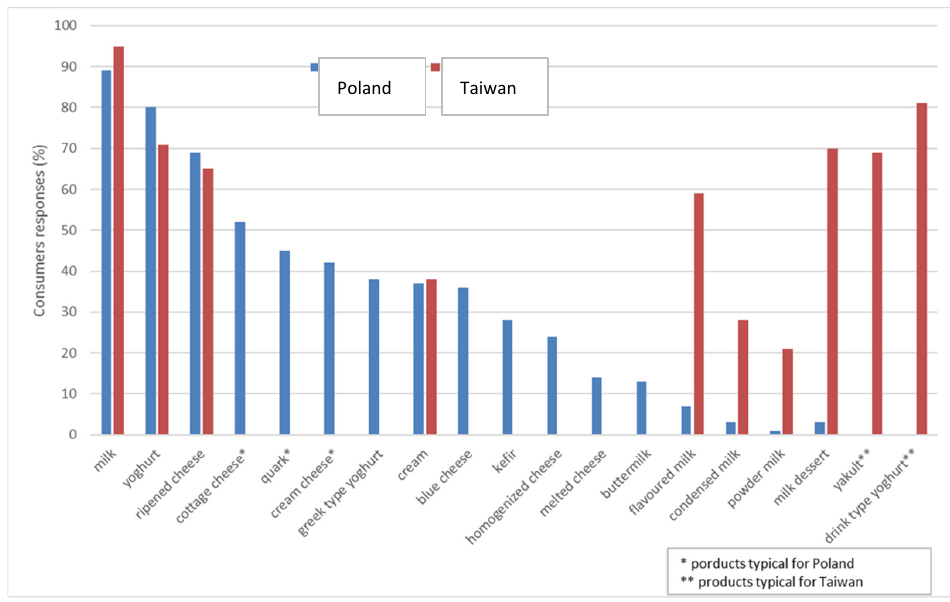
Figure 2. Dairy products declared to be the most consumed by Polish and Taiwanese respondents.